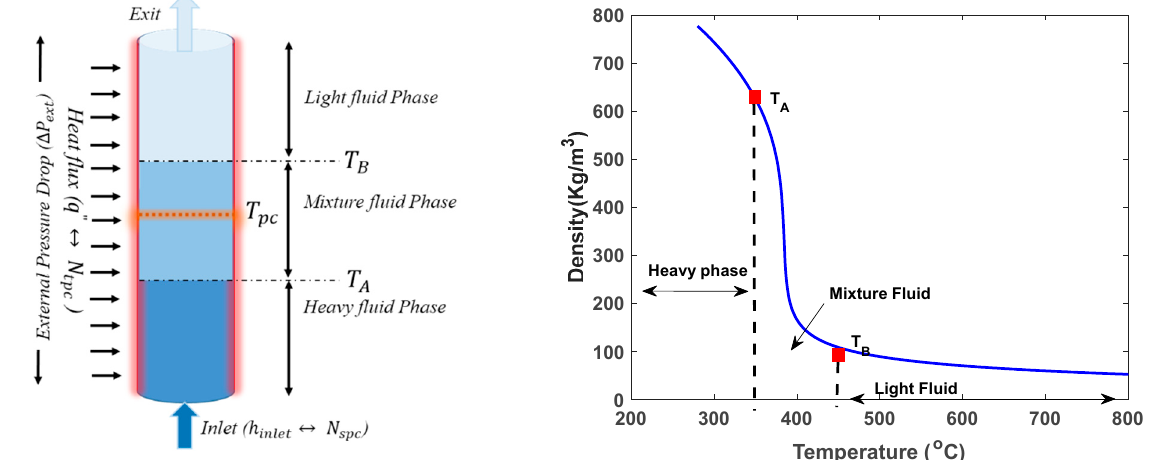
Figure 5. Systematic view of the three-node heated channel.